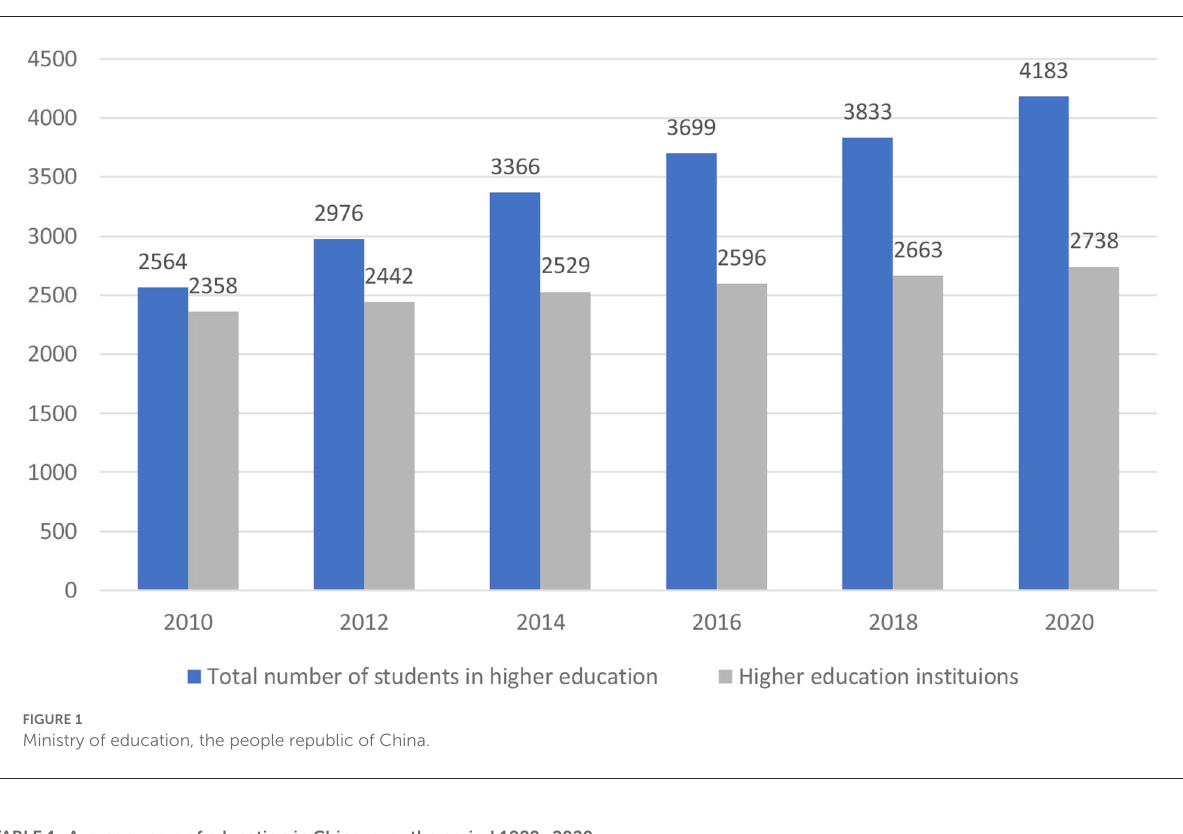
TABLE 1 Average years of education in China, over the period